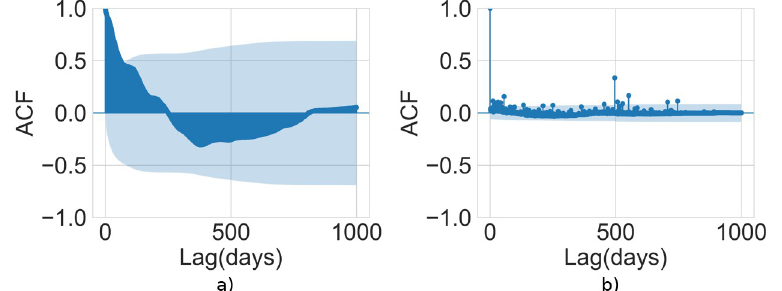
Fig 4. Autocorrelation Functions (ACFs). The autocorrelation function for the a) STEEM price and b) delegation of Steem Power. On the y-axis: the correlation coefficient ρ y ( k ). On the x-axis: the lag k in days. The light cyan area corresponds to the 95% confidence interval for the correlation